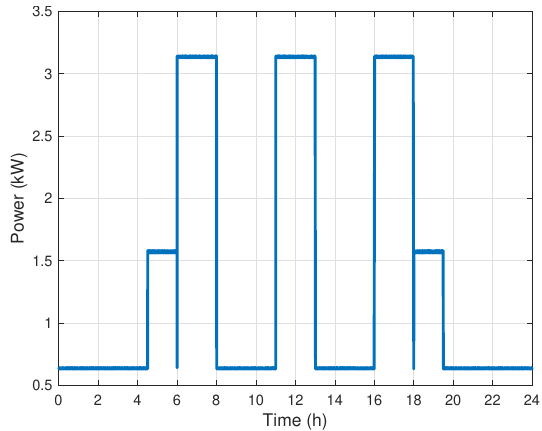
Figure A4. Billeting shelter equipment